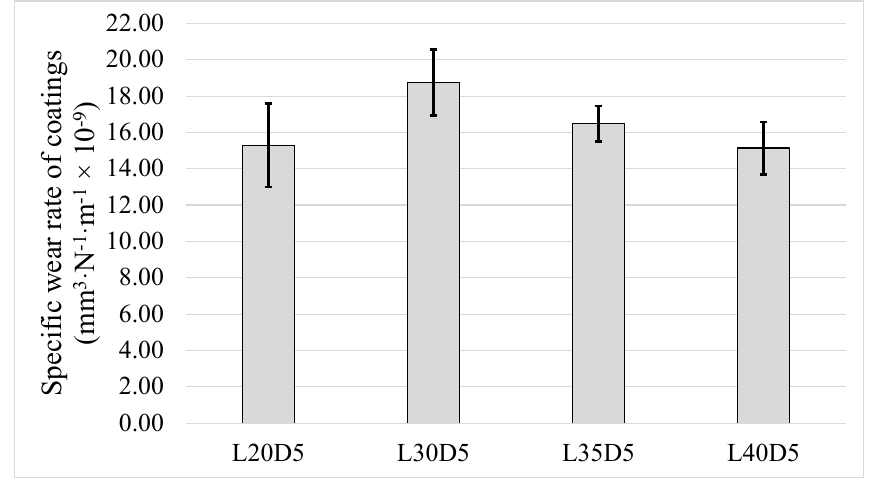
Figure 7. Specific wear rates from ball-on-disc tests conducted under different loads.